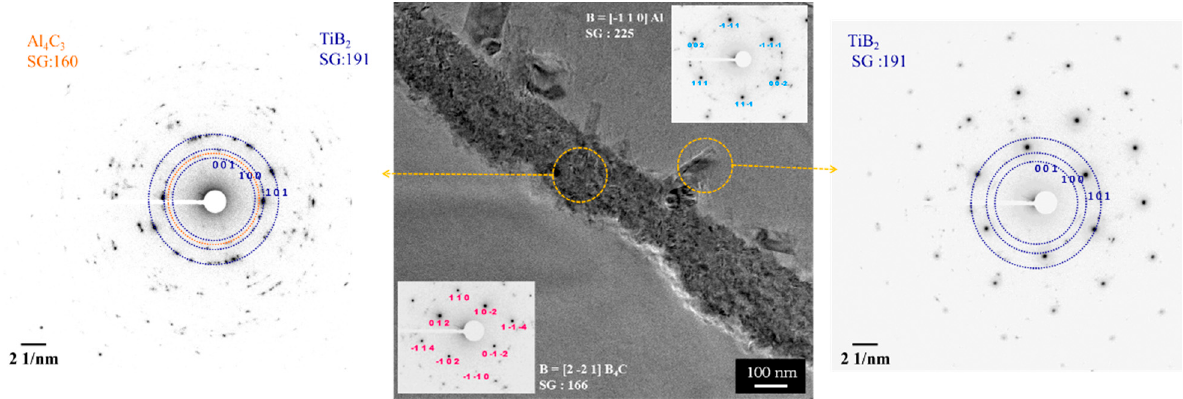
Figure 6. Representative TEM image of interfacial layer in hot-rolled B 4 C/Al6061 matrix and selected area electron diffraction (SAED) patterns of the marked areas.